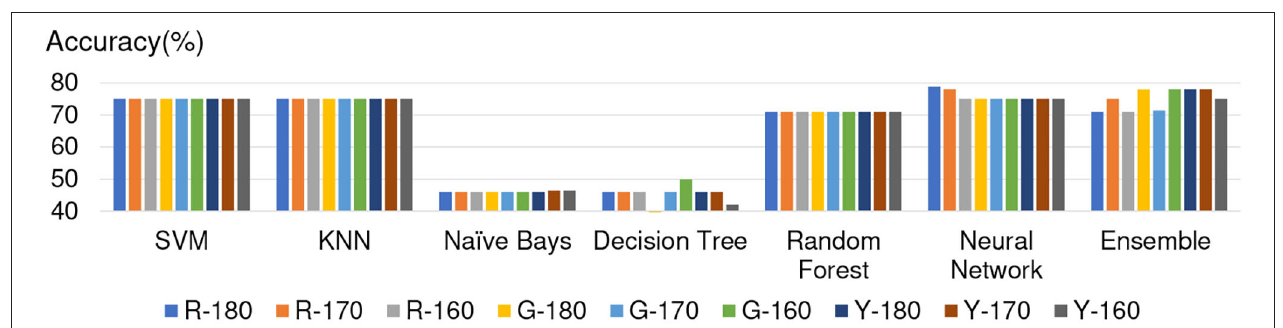
FIGURE 10 | Experimental results of the 5 × 5 image separation.